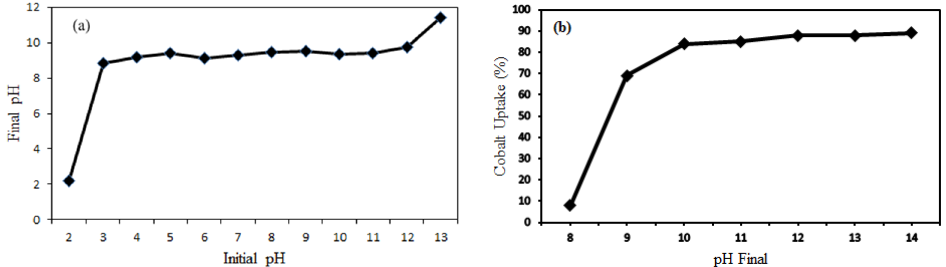
Figure 3. The finding of ( a ) PZC of CNT support, ( b ) Co-Mn adsorption versus pH survey by AAS.